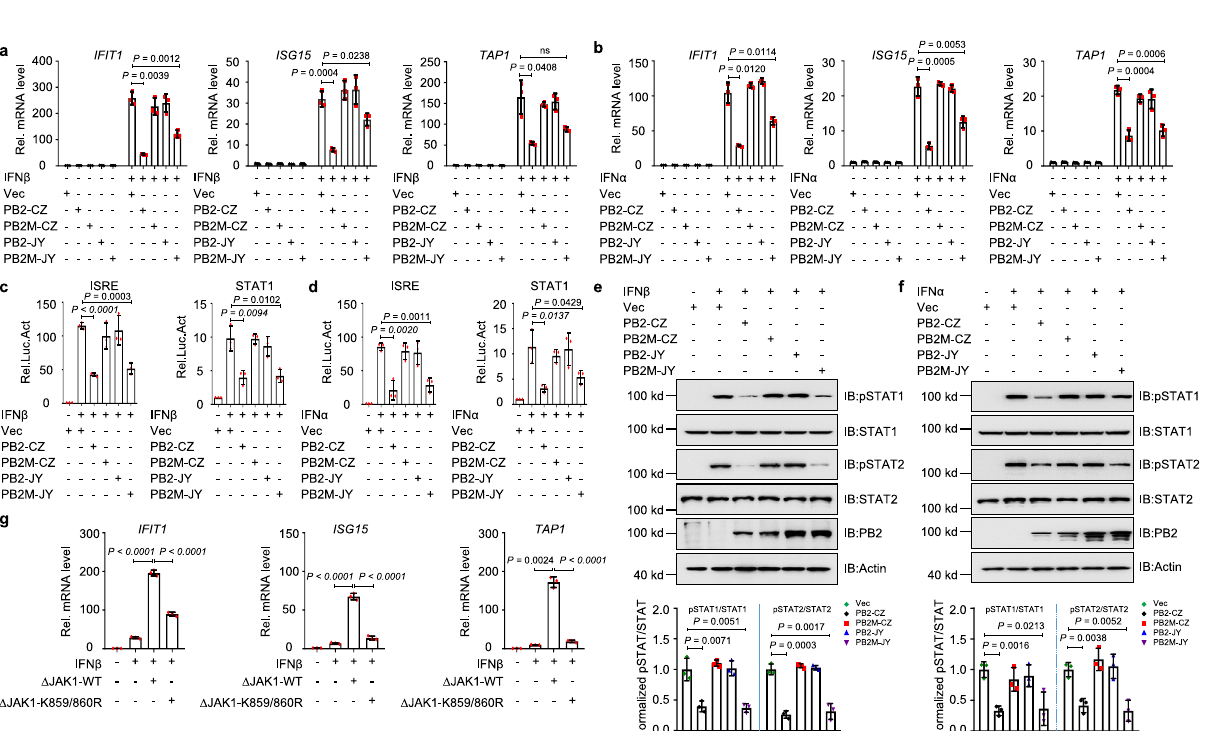
Fig.8 |AIVPB2 inhibitsIFN-mediatedsignalingbyJAK1degradation.a , b qPCR analysis of IFIT1, ISG15 , and TAP1 mRNA in A549 cells transfected with PB2 or its mutant plasmids and treated with IFN β ( a ) or IFN α ( b ) ( n =3 biologically inde- pendentsamples). c , d LuciferaseactivityinHEK293TcellstransfectedwithISREor STAT1 promoter-luciferase reporter, Renilla luciferase plasmid, and PB2 or its mutants plasmids and treated with IFN β ( c ) or IFN α ( d ) ( n =3 biologically inde- pendent samples). e , f Immunoblot analysis of phosphorylated and total STAT in